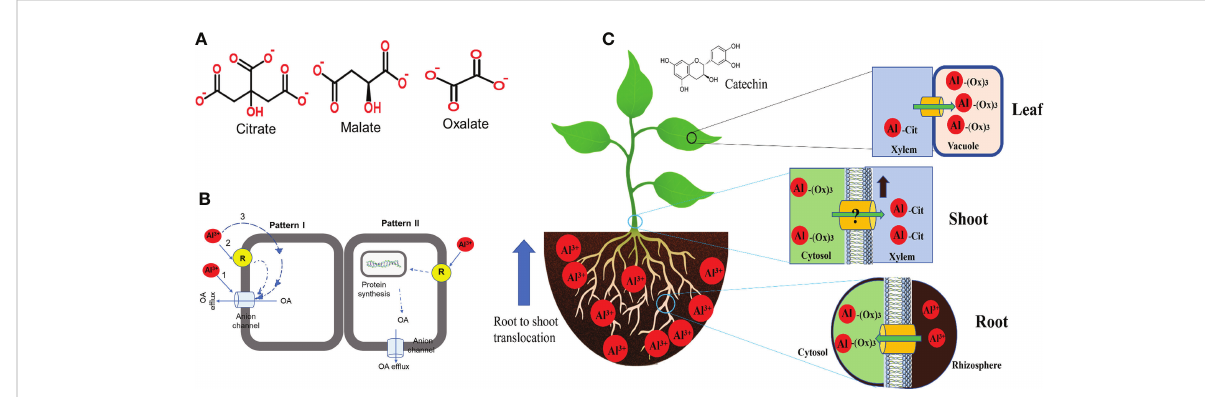
FIGURE 2 Al-induced modes of organic acid (OA) released and internal tolerance in plant roots. (A) Structure of the types of OA exudes by different plant species in response to Al exposure. (B) Proposed mode of Al-induced OA secretion (Modi fi ed from Ma et al. (2001)). (C) Internal detoxi fi cation and compartmentalization of Al in